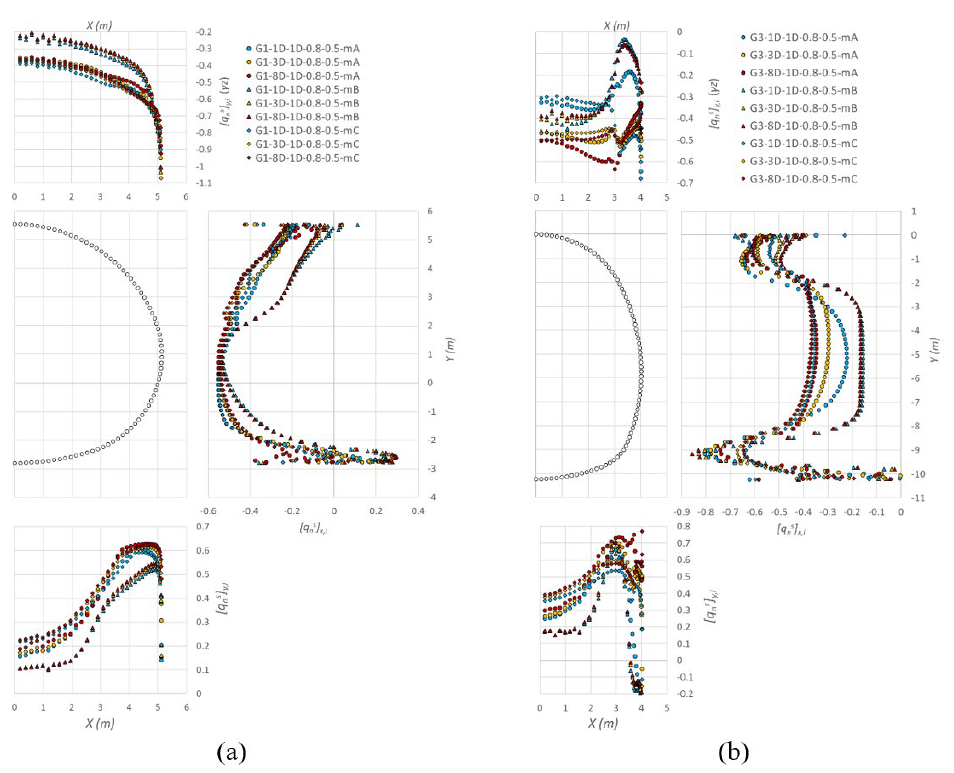
Figure 7. Normalized “ideal” compatibilization load for scenarios: (a) varying cover and materials in geometry G1; (b) varying cover and materials in geometry